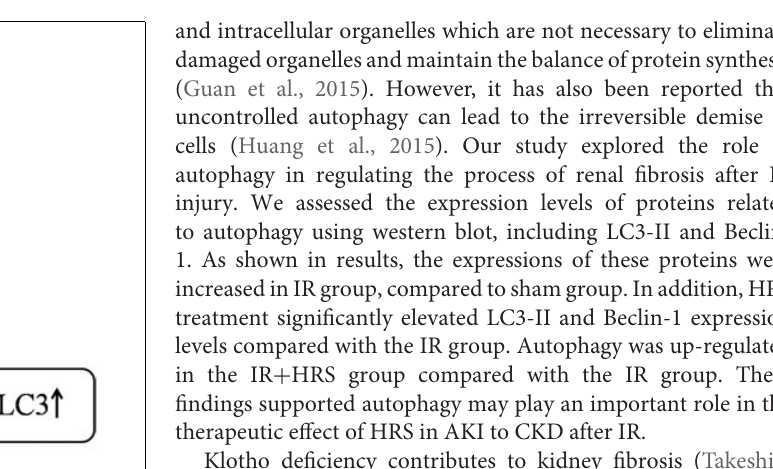
28 days of continuous HRS administration promoted kidney function